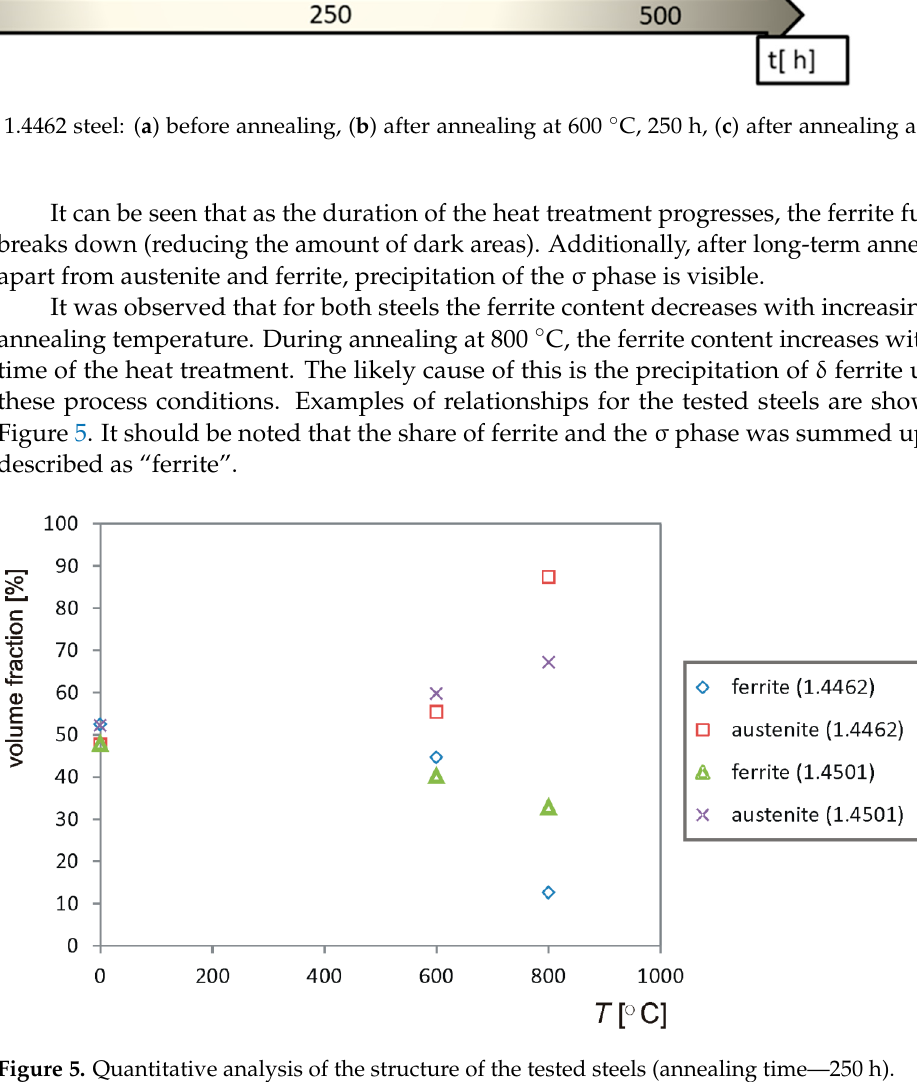
Figure 5. Quantitative analysis of the structure of the tested steels (annealing time—250 h).